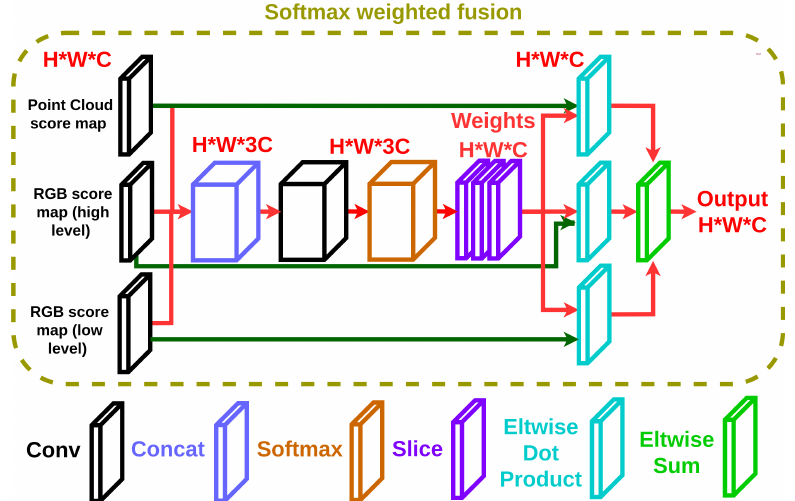
Figure 3. The architecture of the softmax weighted fusion stack. H, W, C are the hight, width and channel number of the feature map. The convolution operation can learn the correlations of the multiple score maps from different modalities to obtain the weight/confidence of each